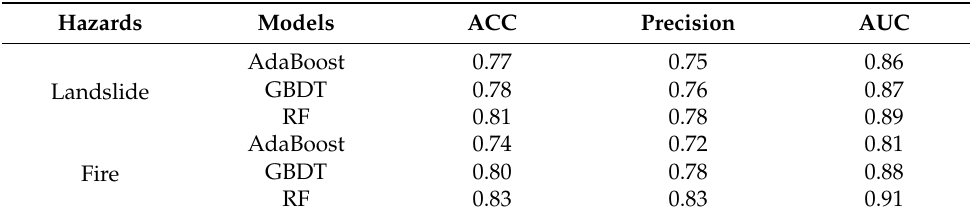
Table 3. Evaluation matrix on the performances of the different models for the two hazards. Hazards Models ACC Precision AUC AdaBoost Landslide